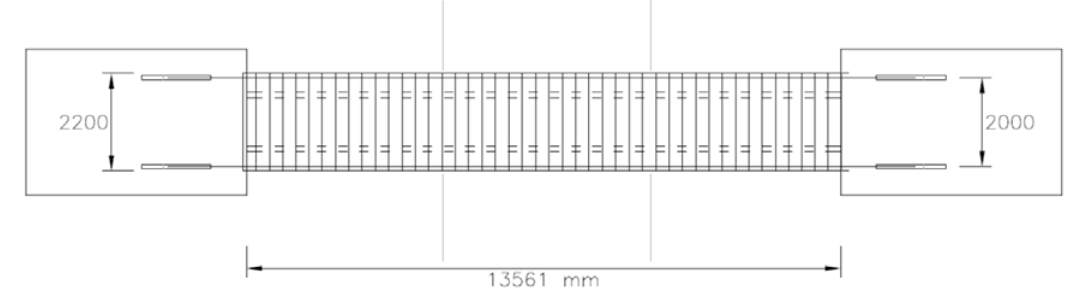
Fig. 20 Plan view